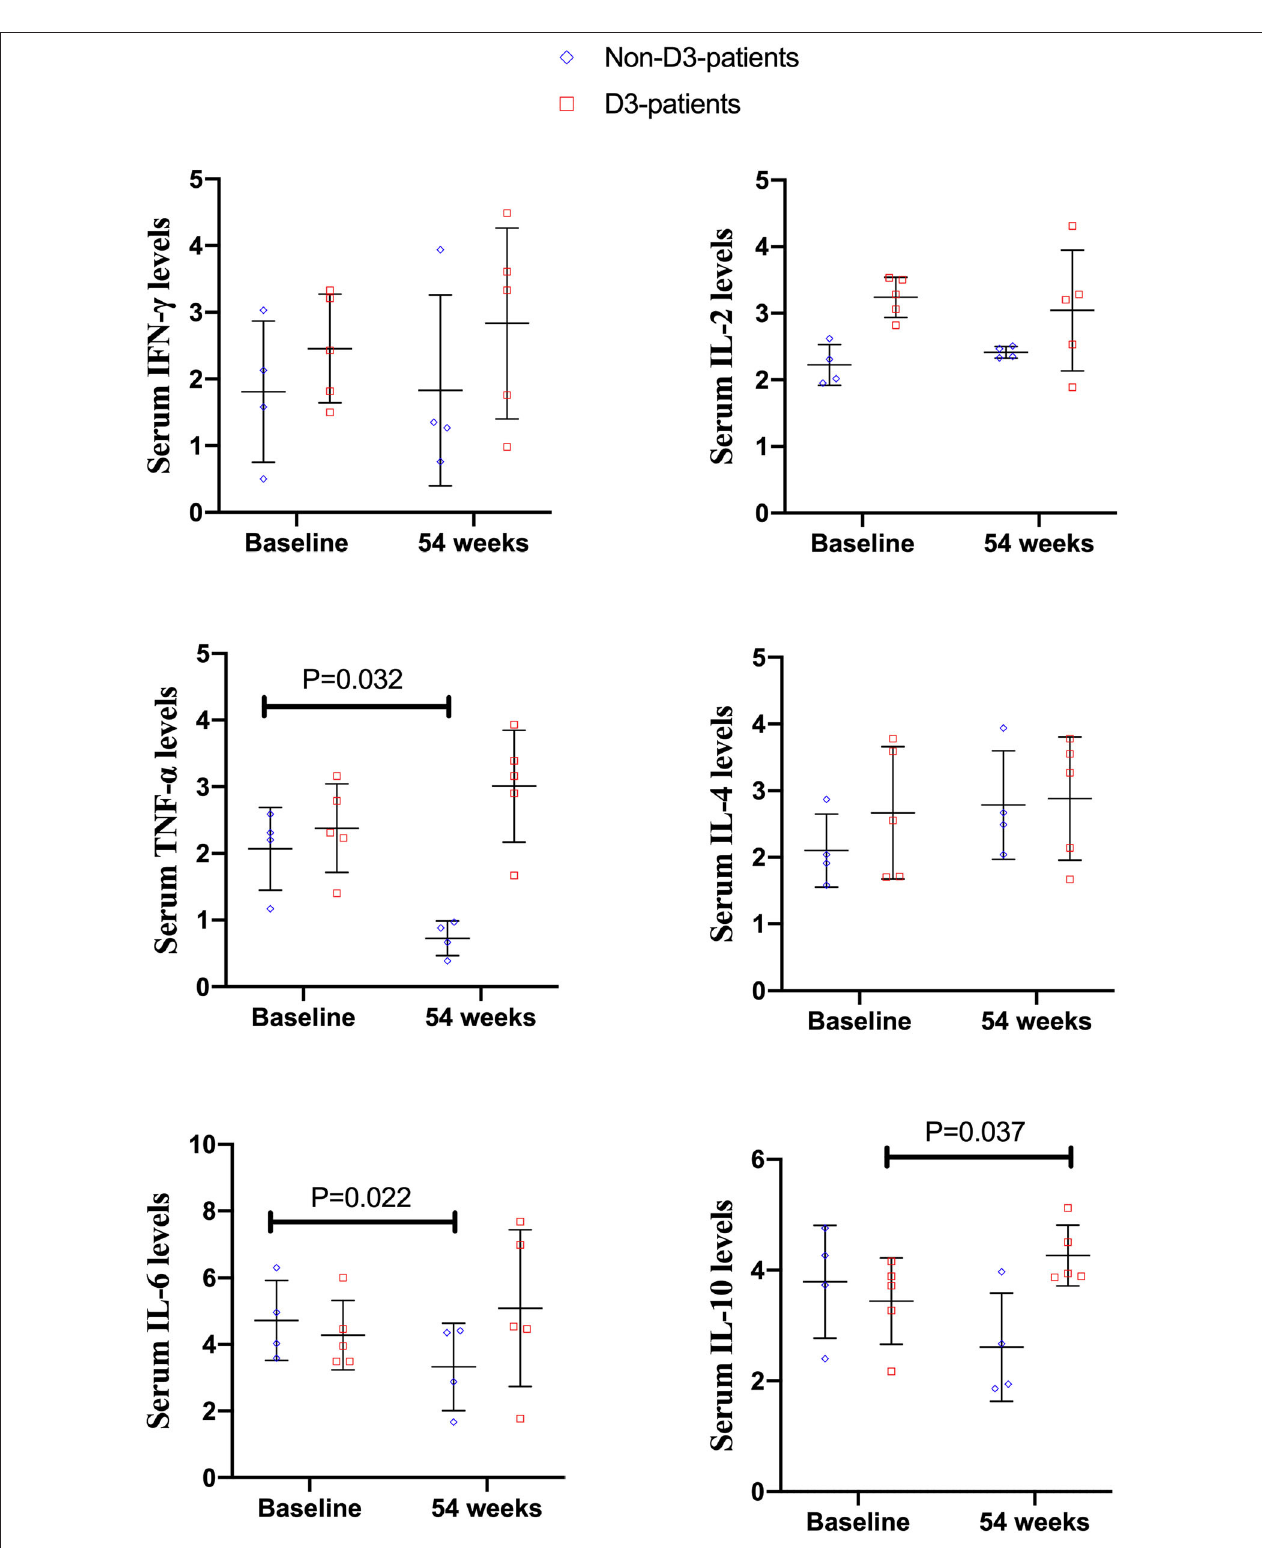
FIGURE 6 | The changes of cytokines levels between baseline and 54 weeks in CD patients receiving IFX therapy.